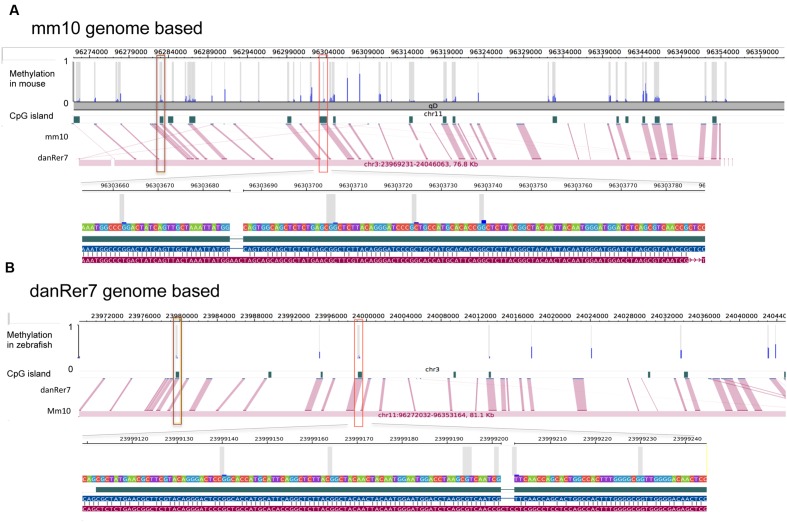
Methylation of shared CpG islands in mouse and zebrafish genome are overall at a low level. Each detected CpG site is marked with gray bar and methylation status is shown by blue bar ranging from 0 to 1. CpG islands are annotated based on reference genome mm10 (A) and danRer7 (B), respectively. Pinked lines link corresponding CpG islands, two orthologous CpG islands are marked with brown and red squares.